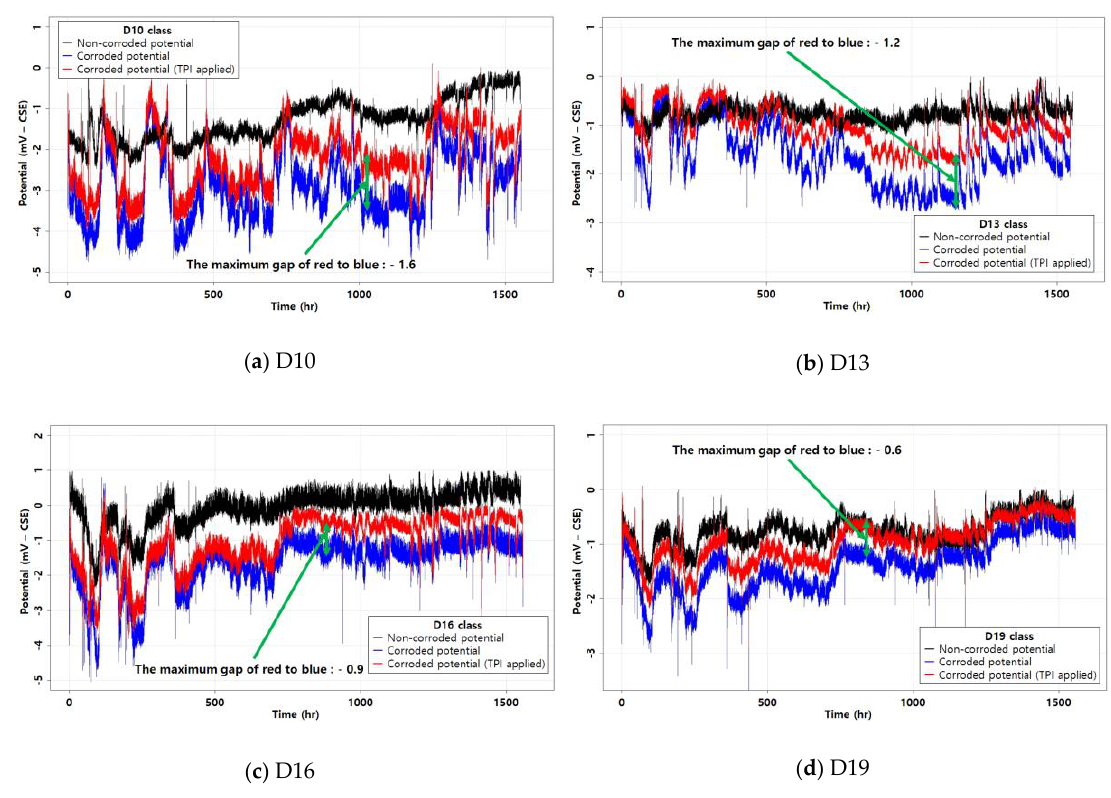
Figure 6. The results of removing the temperature effect: ( a ) D10; ( b ) D13; ( c ) D16; ( d ) D19.